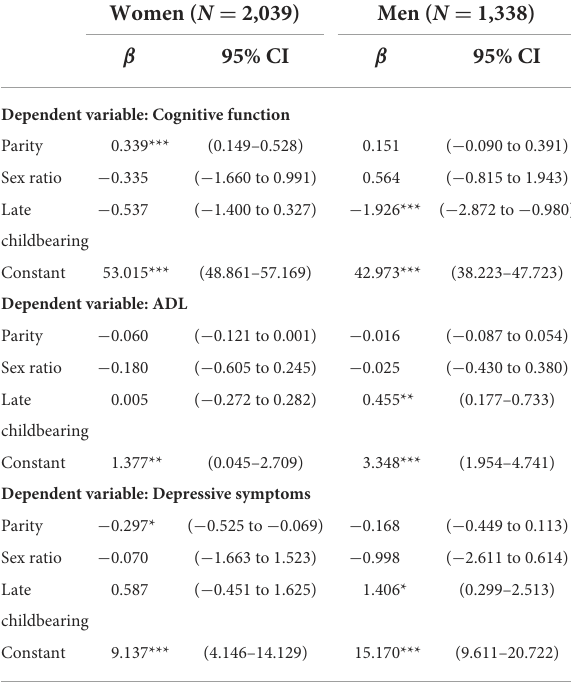
TABLE 3 Linear regression models examining the association between reproductive history and multidimensional health ( N = 3,377).